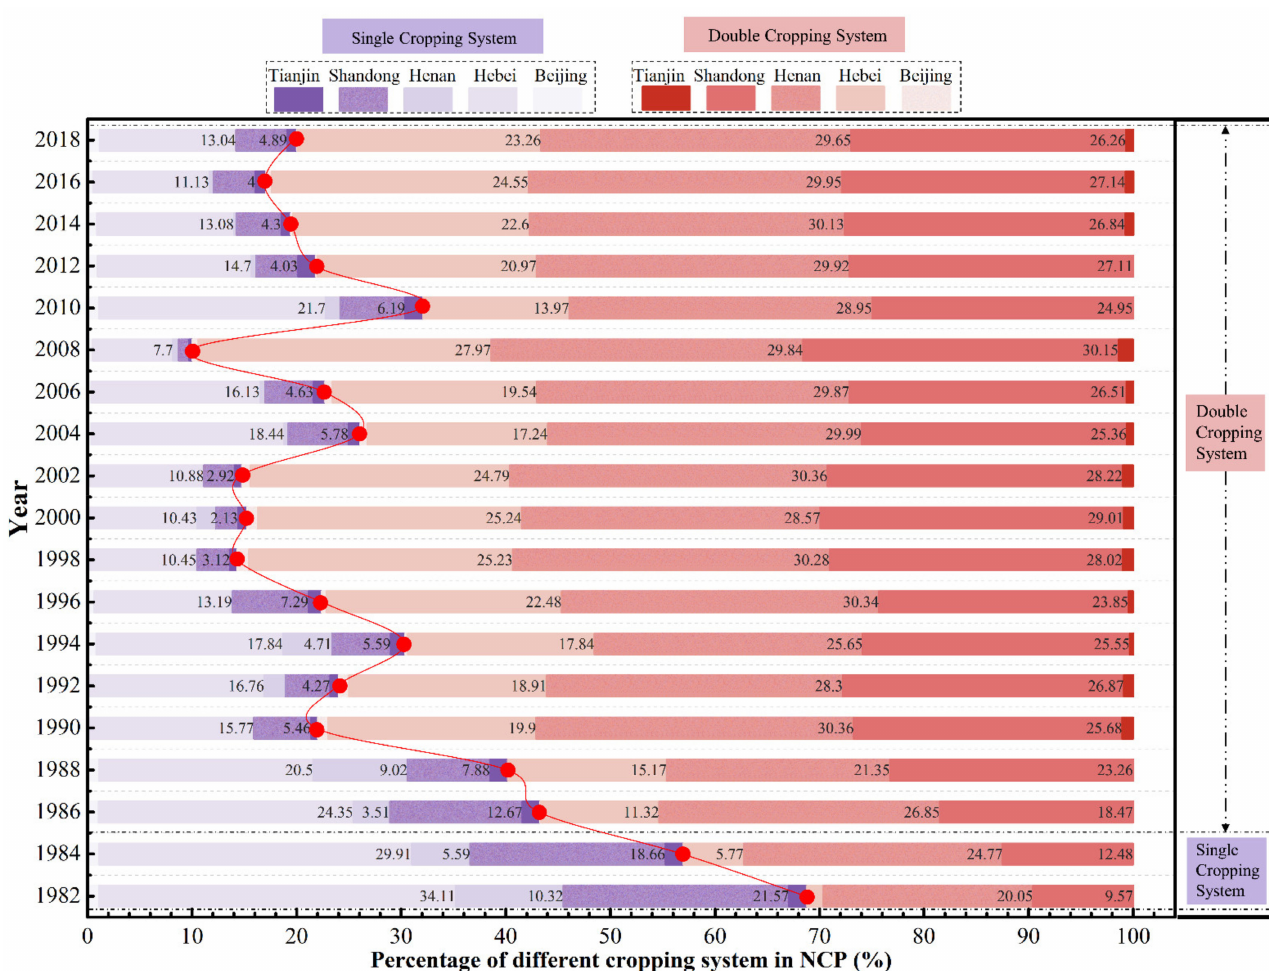
Figure 12. Percentage areas of cultivated land where different cropping systems were used on the NCP from 1982 to 2018. In terms of different provinces and cities, apart from a few fluctuations, the proportions stable from 1982 to 2018. The use of the SCS declined sharply in Hebei, Henan and Shandong during the 36-year period, with the greatest decrease being in Shandong, where the proportion of land fell from 21.57% in 1982 to only 0.99% in 2008 before rising slightly to 4.89% in 2018. In contrast, there was rapid growth in the use of the DCS in these three provinces, with the growth in Hebei being most obvious—from 1.56% in 1982 to 23.26% in